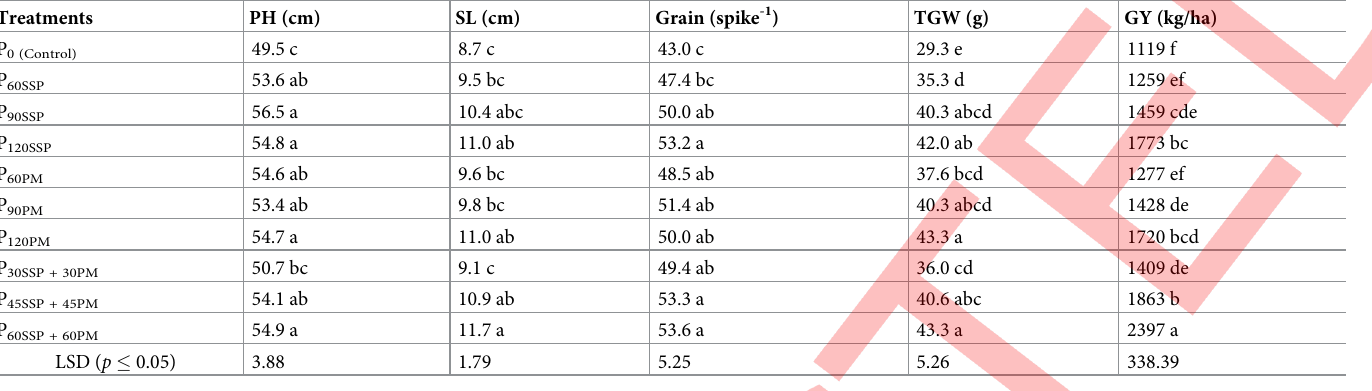
Means sharing same letter could not differ significantly at 5% probability